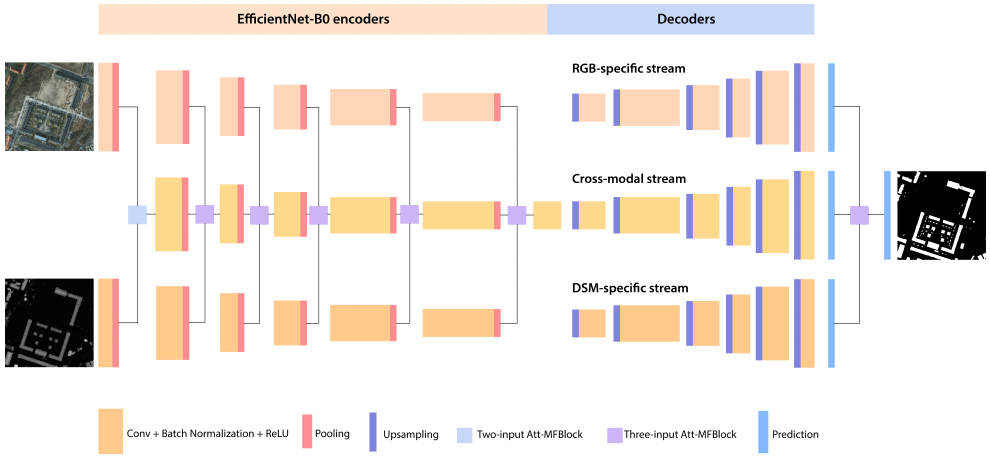
Figure 2. Scheme of the HAFNetE